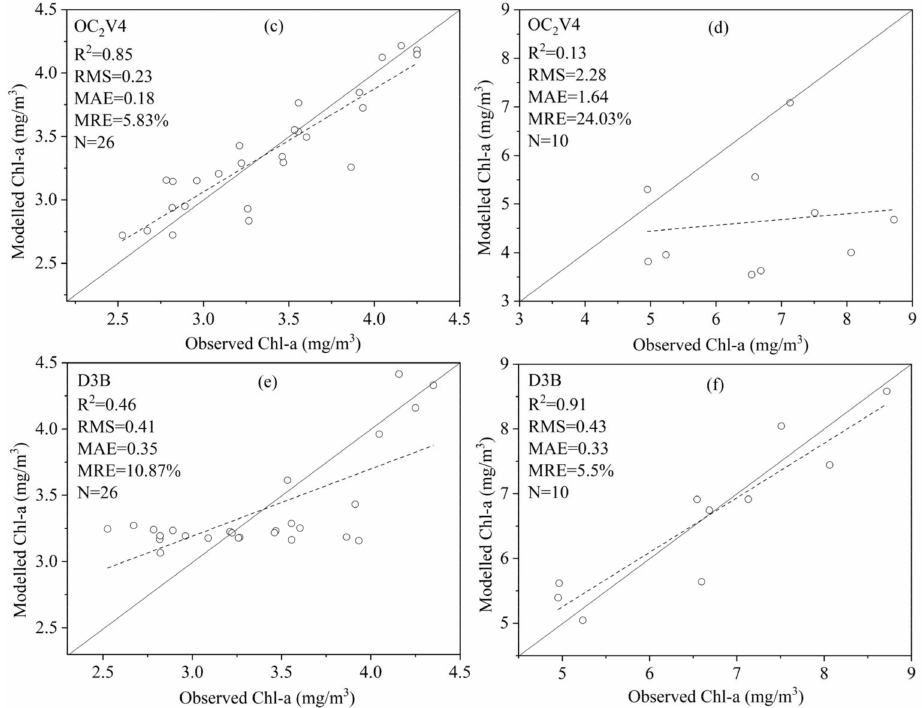
Figure 7. In situ chl-a versus estimated chl-a of X 6 , OC2V4 and D3B in the two separate chl-a